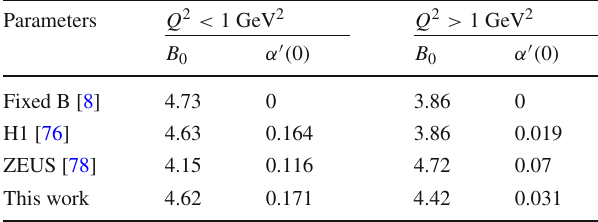
Table 1 Parameters B 0 and α (cid:2) ( 0 ) of the diffraction slope B obtained by a fit to different data sets at HERA in photo- ( Q 2 < 1 GeV 2 )